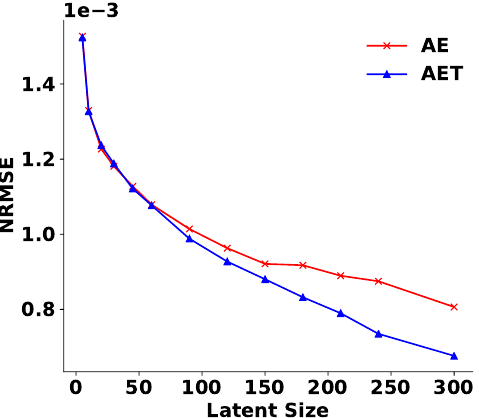
Figure A1. Improvement of PD errors with the Tucker decomposition. The x -axis is the bottleneck layer size of the AEs.